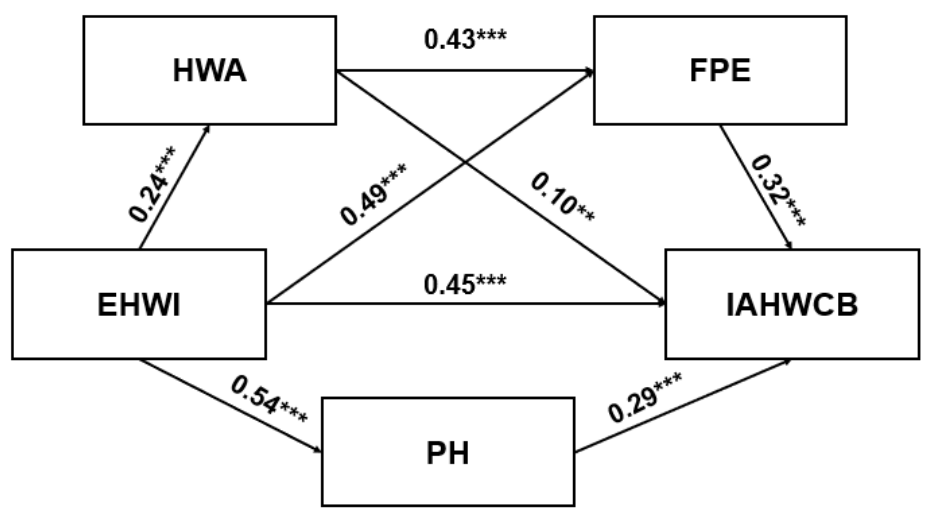
Figure 2. The effects of predictors of intention to acquire healthy weight-control behaviors. ** p < 0.01